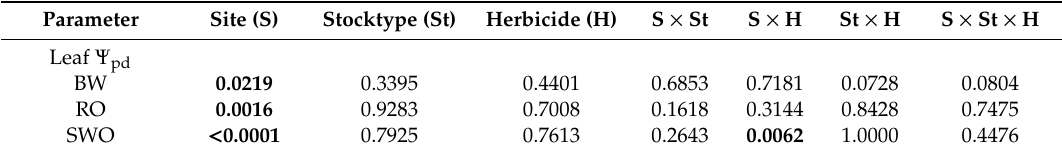
Table 4. Analysis of variance test results for pre-dawn leaf water potential.